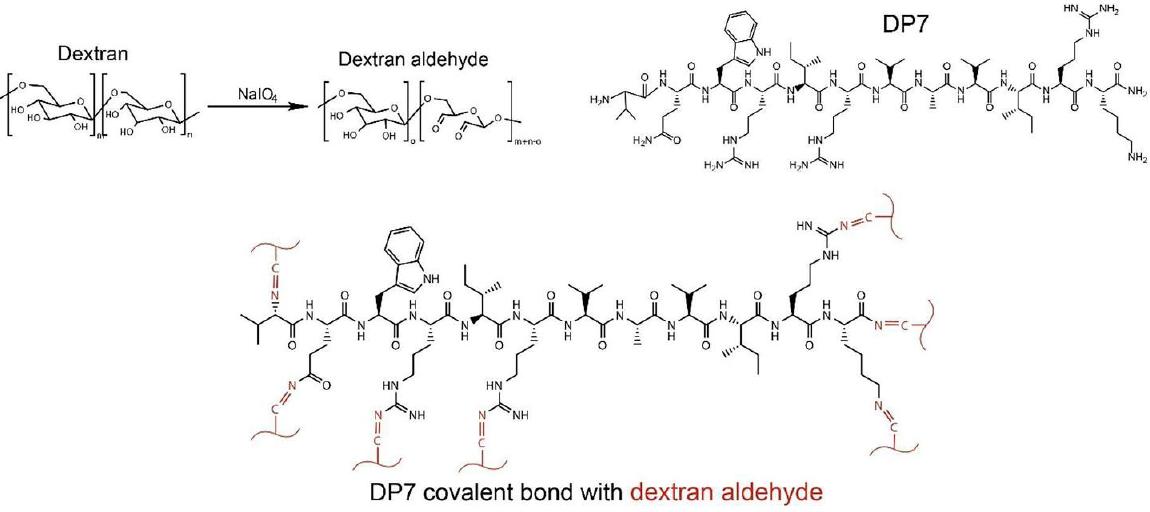
Figure 6. Dextran-based hydrogel bio-adhesive: chemical reaction mechanisms in hydrogel bio-adhesive. Reprinted with permission from ref [101]. Copyright 2022 Elsevier.